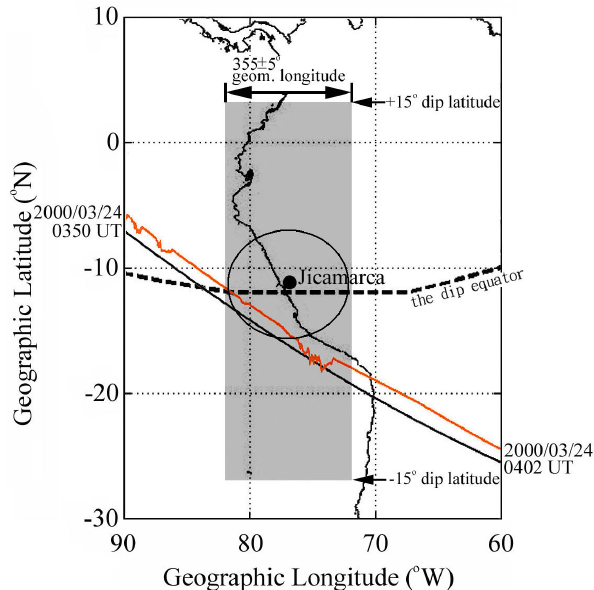
Fig. 1. The location of Jicamarca digisonde (black dot) and the area for ROCSAT-1 data selection (shaded area). The solid circle represents the wide beam of the digisonde transmit antenna at 600- km altitude. The shaded area is through ± 15 ◦ dip latitudes and 355 ± 5 ◦ geomagnetic longitudes. An example of a ROCSAT-1 pass (solid line) and the associated ion density measurement (red line) is during 03:50–04:02 UT on 24 March 2000.